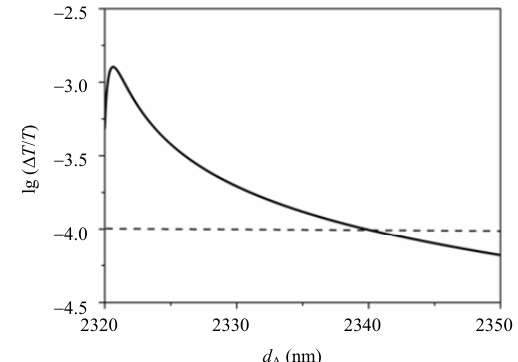
Fig. 6 Values of lg (  T / T ) based on the increment  d = 0.001 nm.